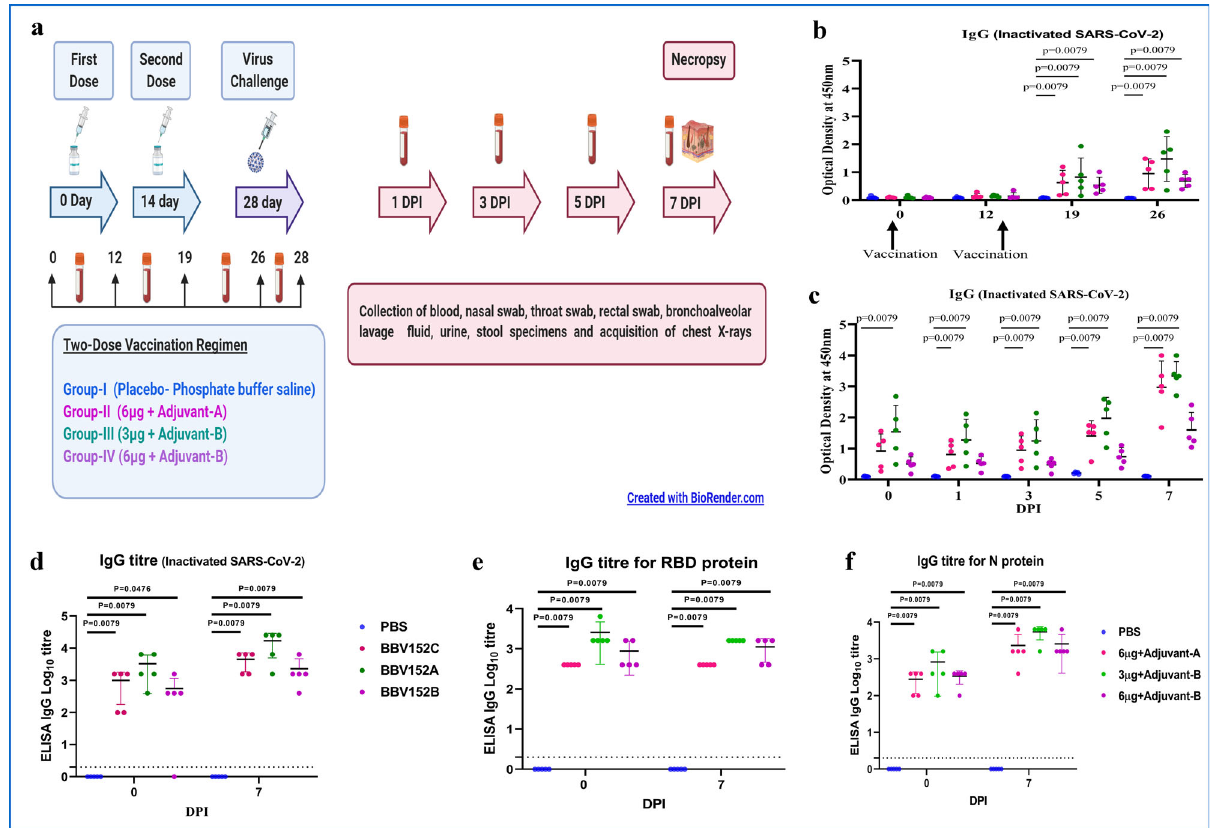
Fig. 1 Experimental summary and IgG response in vaccinated animals. a Diagrammatic representation of experiment summary. b Anti-SARS-CoV-2 IgG response in animals from 1st to 4th week of immunisation with whole virus-inactivated protein ELISA. c Anti-SARS-CoV-2 IgG response at 0, 1, 3, 5 and 7 DPI. d Anti-SARS-CoV-2 IgG titres in animals at 0 and 7 DPI. e IgG titres for SARS-CoV-2 RBD protein in animals at 0 and 7 DPI. f IgG titres for SARS- CoV-2 nucleoprotein in animals at 0 and 7 DPI. The statistical signi fi cance was assessed using the Kruskal – Wallis test followed by the two-tailed Mann – Whitney test between two groups; P values of < 0.05 were considered to be statistically signi fi cant. The dotted line on the fi gures indicates the limit of detection of the assay. Data are presented as mean values + / − standard deviation (SD). Statistical comparison was done by comparing the vaccinated group with the placebo group as a control. Group I = blue, group II = pink, group III = green and group IV = purple, number of animals = 5 animals in each group. Source data are provided as a Source Data fi